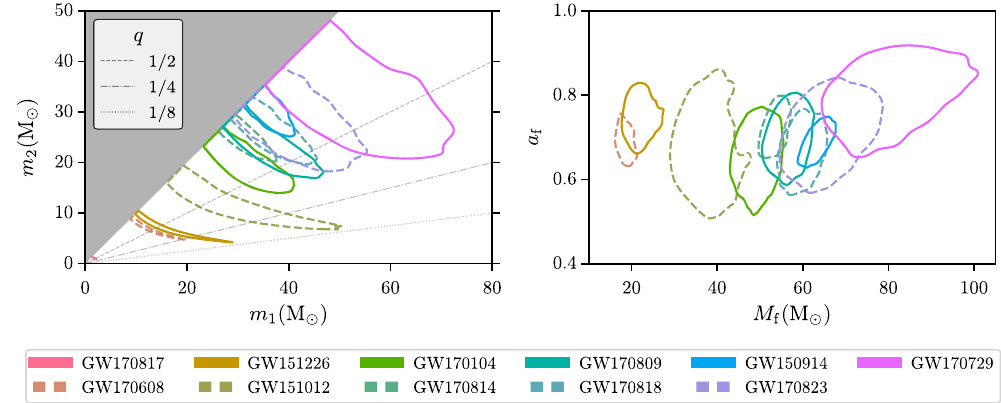
FIG. 4. Parameter estimation summary plots I. Posterior probability densities of the component masses and final masses and spins of the GW events. For the two-dimensional distributions, the contours show 90% credible regions. Left: Source-frame component masses m m m ≥ m 1 and 2 . We use the convention that 1 2 , which produces the sharp cut in the two-dimensional distribution. Lines of constant mass ratio q ¼ m 2 =m 1 are shown for 1 =q ¼ 2 , 4, 8. For low-mass events, the contours follow lines of constant chirp mass. Right: The mass M f and dimensionless spin magnitude a f of the final black holes. The colored event labels are ordered by source-frame chirp mass. The same color code and ordering (where appropriate) apply to Figs. 5 –